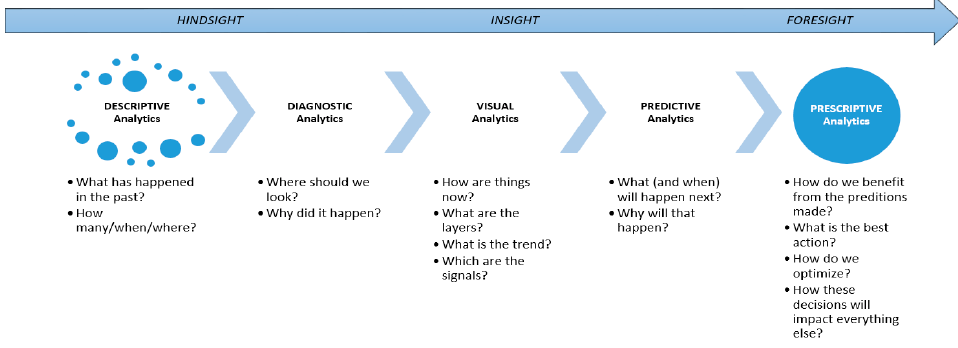
Figure 2. MAs’ tasks in the era of Big Data and Business Analytics.